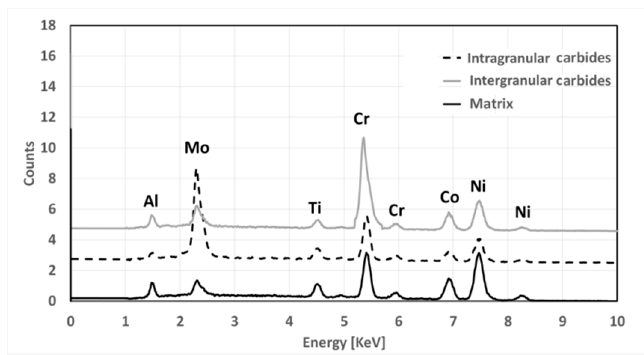
Figure 12. HT samples after solutioning ( a ), after first aging ( b ) and after second aging ( c ). In Figure 13, EDS spectra show the chemical composition of carbides relative to their location.